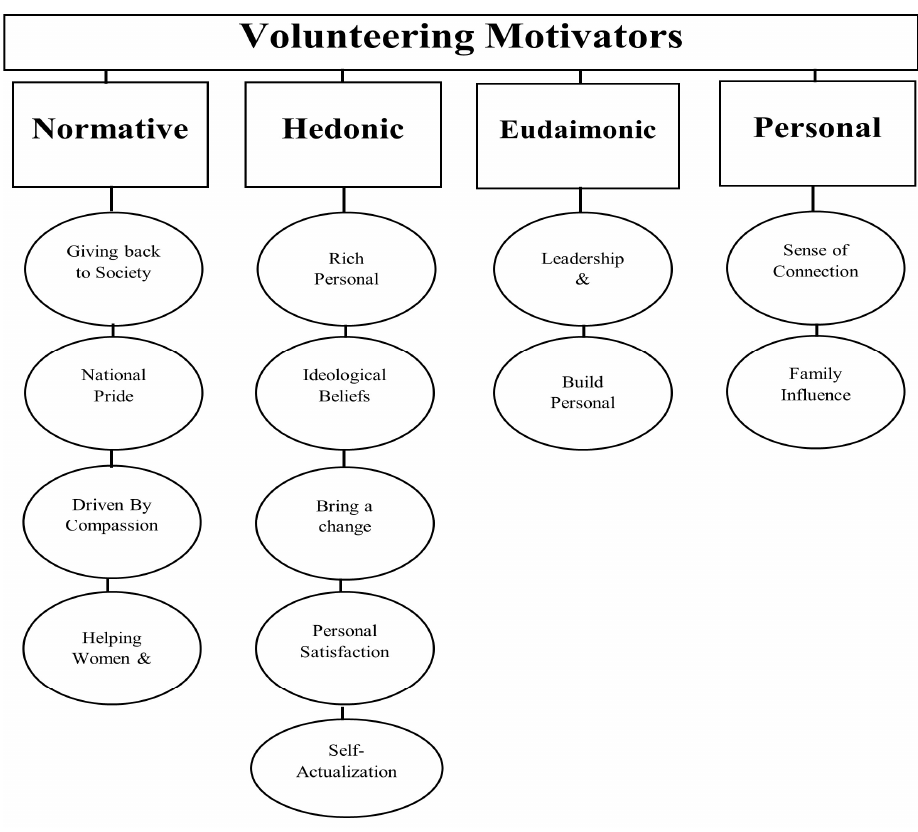
Figure 1. Volunteering motivators of Polish youths during crises.